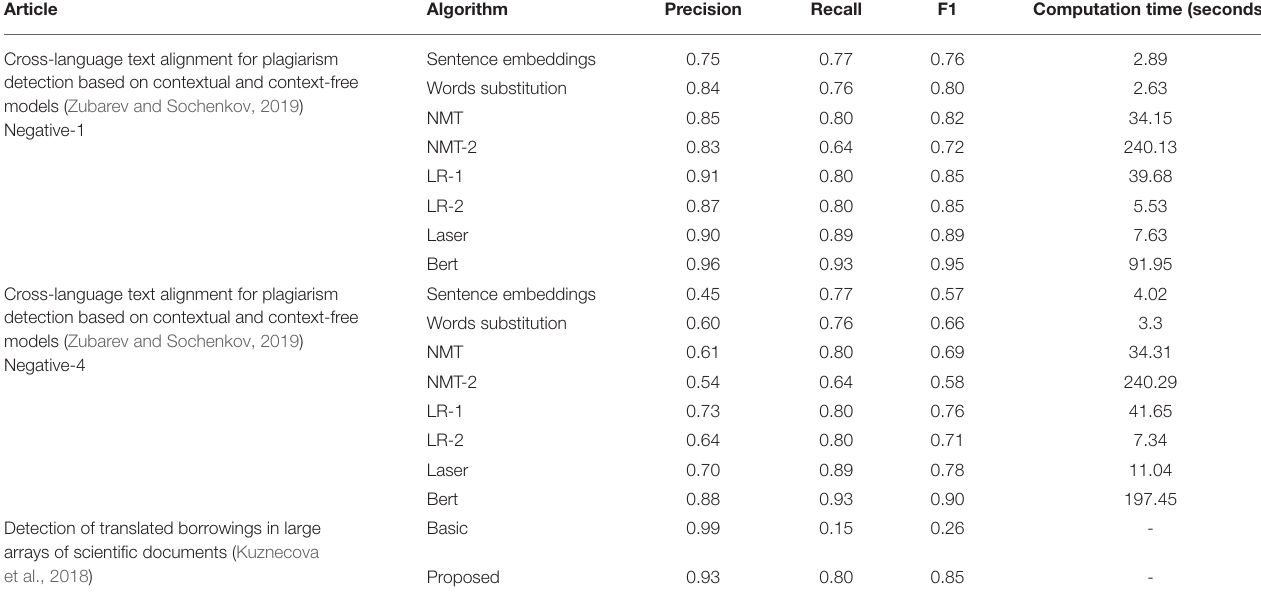
TABLE 4 | A quantitative analysis of the effectiveness of methods for a Russian-English pair.